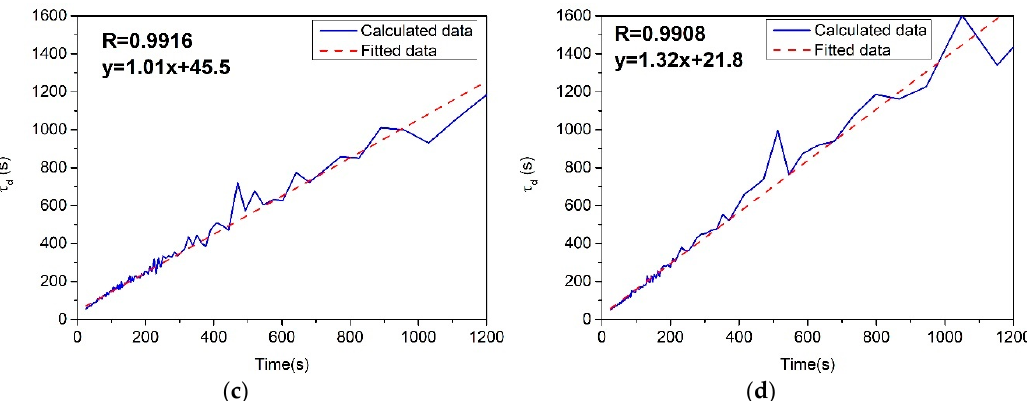
Figure 5. Relationship between time coefficient and time, and fitting curve. ( a ) results of test (a); ( b ) results of test (b); ( c ) results of test (c); ( d ) results of test